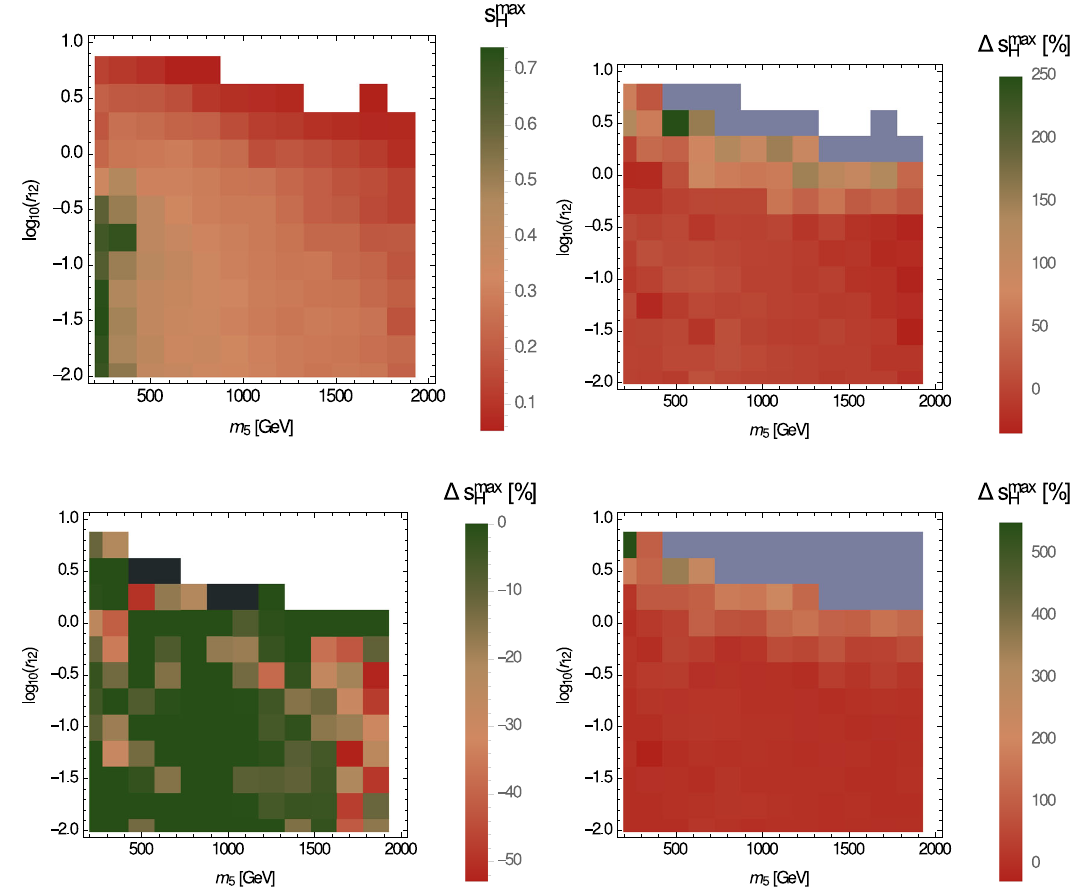
vacuum stability constraints are combined with the weak perturbativity cuts (left), or the one-loop vacuum stability is checked but the pertur- bativity constraints are not applied (right). The purple regions are not accessible if the tree-level cuts are applied. In the black bins, no point wasfound inour random scanafterapplying theone-loop perturbativity constraints on points with a stable tree-level